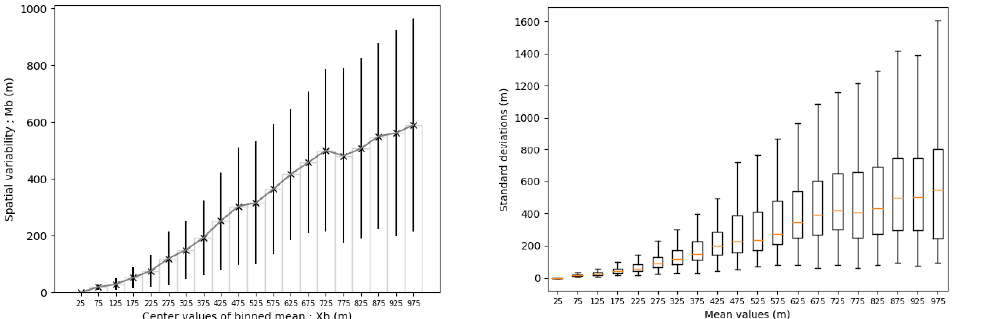
Figure 6. Left panel: Mean spatial variability ( M b ) of visibility classes ( C b ) in function of binned mean visibility ( X b ) with error bars given by the standard deviations of the classes ( C b ). Right panel: Boxplots ( BP b ) for each class ( C b ). The bins are indicated in light gray.